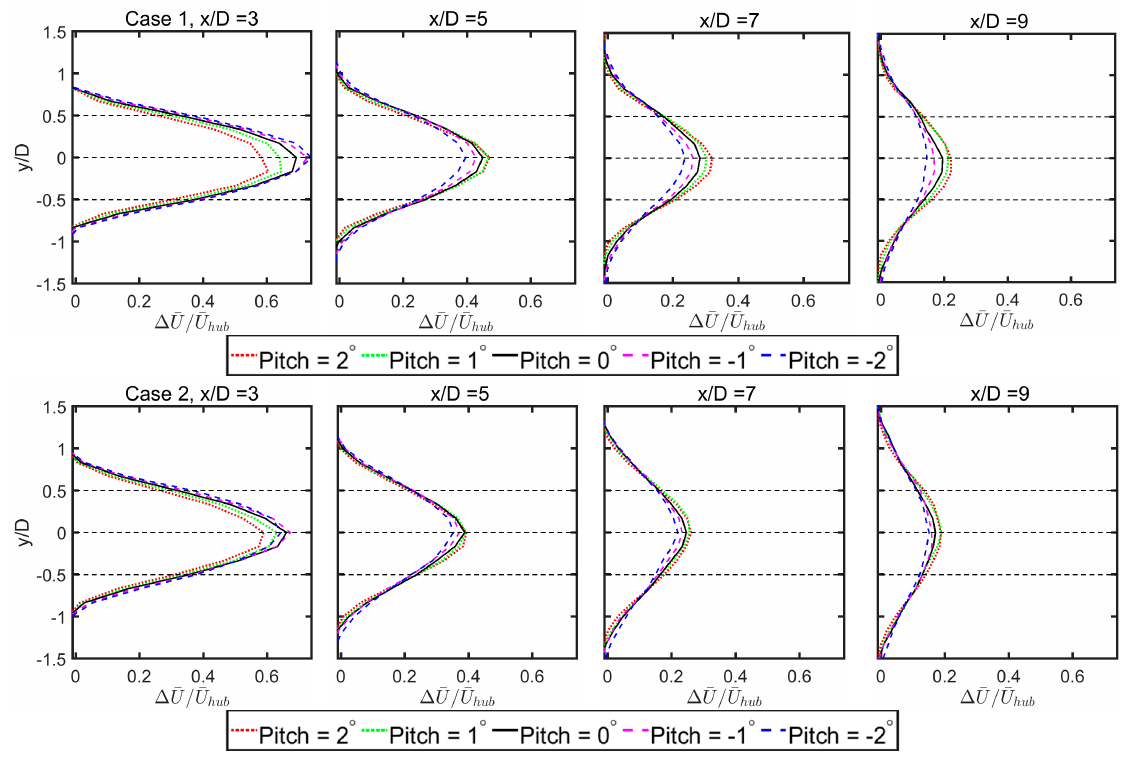
Figure 3. Spanwise profiles of the normalized velocity deficit at the hub height for a turbulence intensity of 4.3% ( top ) and 6.3% ( bottom ) for the incoming flow.